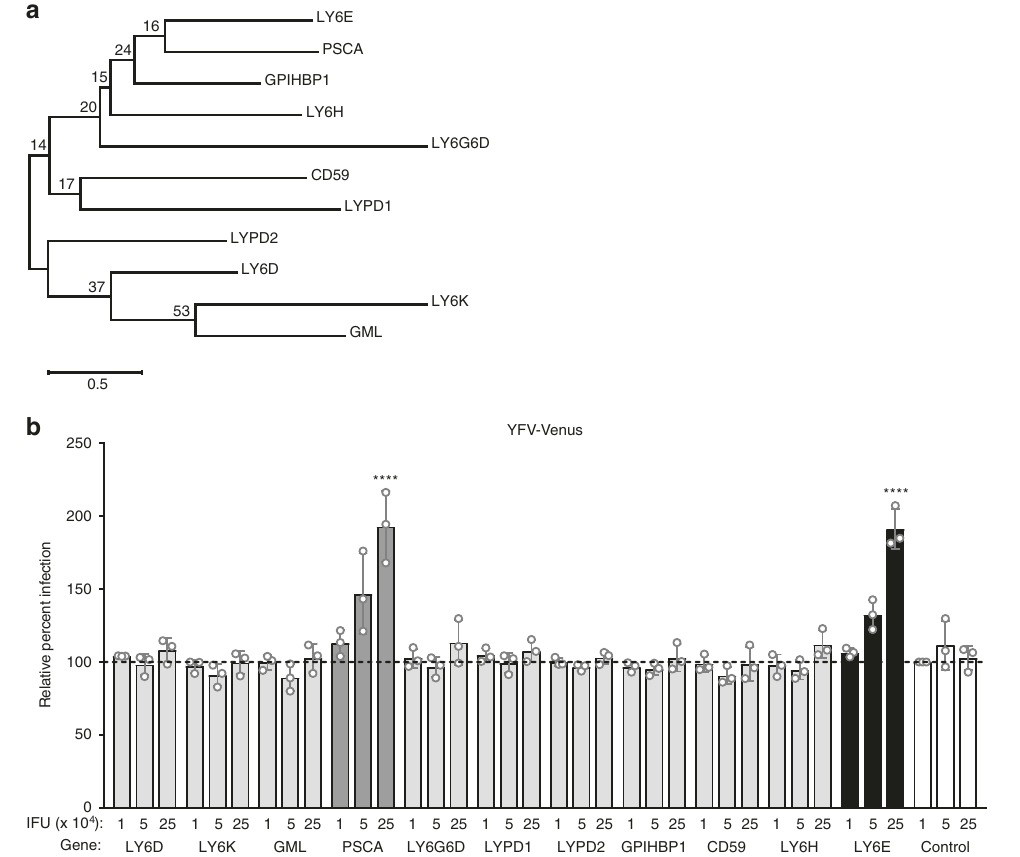
Fig. 2 A related LY6/uPAR protein enhances yellow fever virus infection. a Molecular phylogenetic analysis by maximum likelihood method. The evolutionary history of LY6/uPAR family proteins was inferred by using the maximum likelihood method based on the JTT matrix-based model 64 . Bootstrap values resulting from 1000 replicates are shown next to the branches. The tree is drawn to scale, with branch lengths measured in the number of substitutions per site. Evolutionary analyses were conducted in MEGA7. b STAT1 -/- fi broblasts transduced with three doses of lentivirus (1 × 10 4 , 5 × 10 4 , 2.5 × 10 5 infectious units or IFU) expressing LY6/uPAR family members or fl uc control were infected with YFV-17D-Venus (0.5 MOI, 24 h, control average 28.3% infection). Percent infection was quanti fi ed by fl ow cytometry and is shown normalized to cells transduced with 1 × 10 4 IFU fl uc lentivirus. n = 3 biological replicates. **** p < 0.0001. SD is shown. Data were analyzed prior to normalization by ordinary two-way ANOVA with Dunnett ’ s multiple comparisons test, which measured infectivity of LY6 family members relative to fl uc control for each respective dose of lentivirus